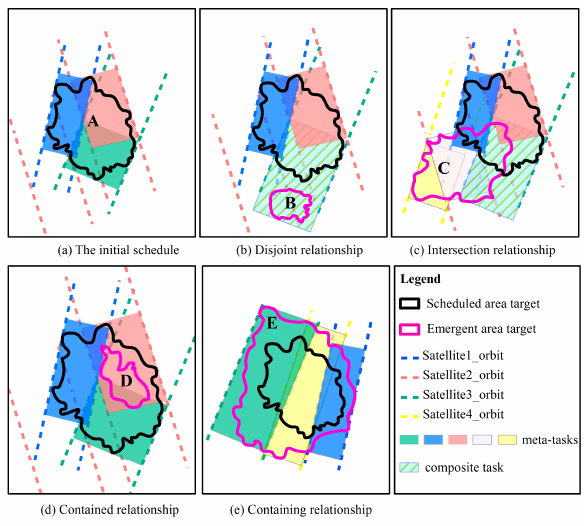
Figure 3. Spatial relationships between scheduled task and emergent